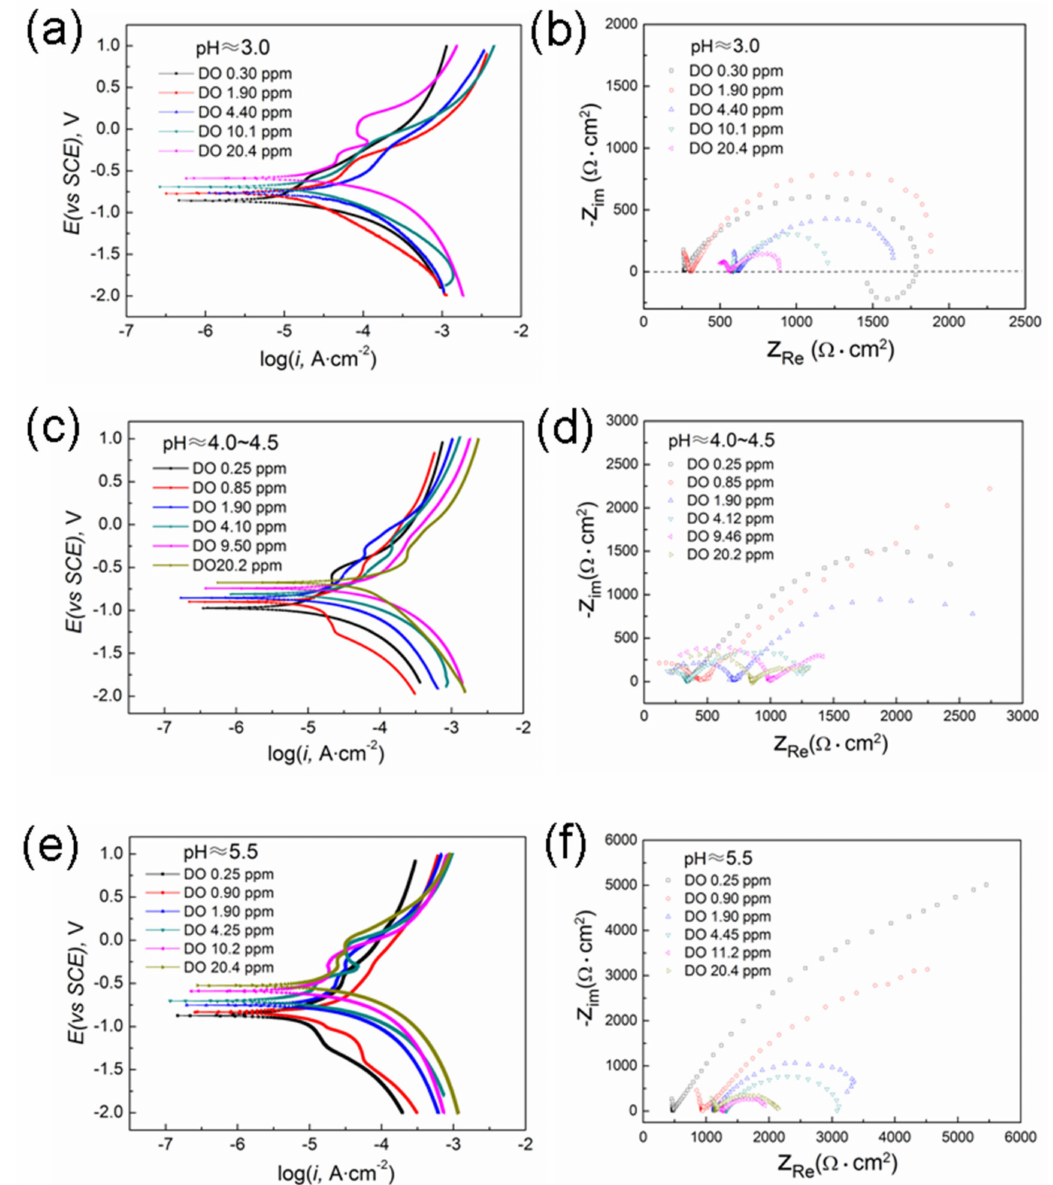
Figure 2. Tafel curves ( a , c , e ) [24] and Nyquist diagrams ( b , d , f ) for X80 steel in the acidic soil simulated solutions with various and pH and dissolved oxygen (DO)